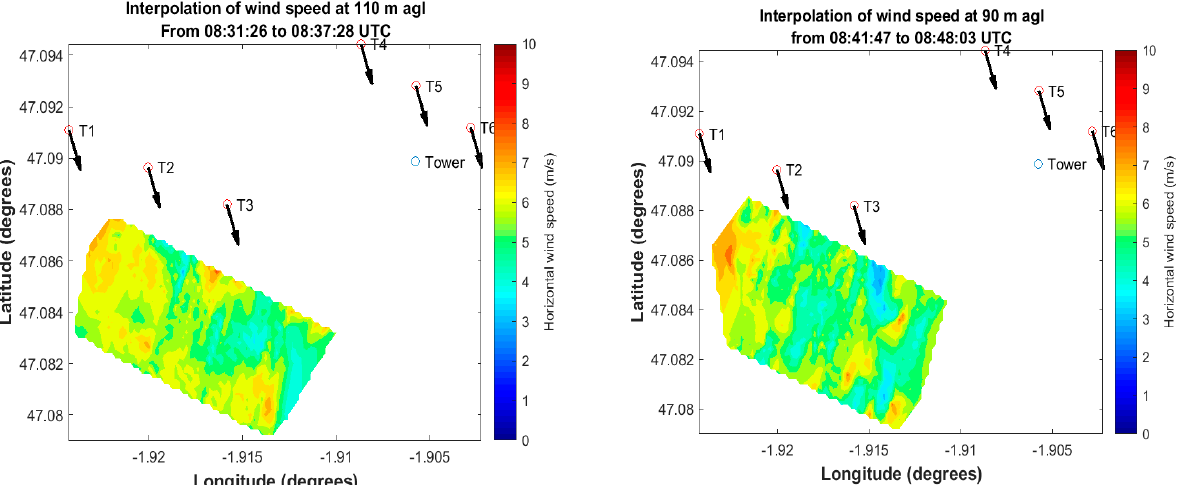
Figure 10. 2-D fields of the horizontal wind speed measured on 28 April at different moments. Left plot: at 110 m (agl) when T2 and T3 were not functioning. Right plot: at 90 m (agl) after the T3 turbine restarted. The black arrows represent the wind direction average during the flight phase.